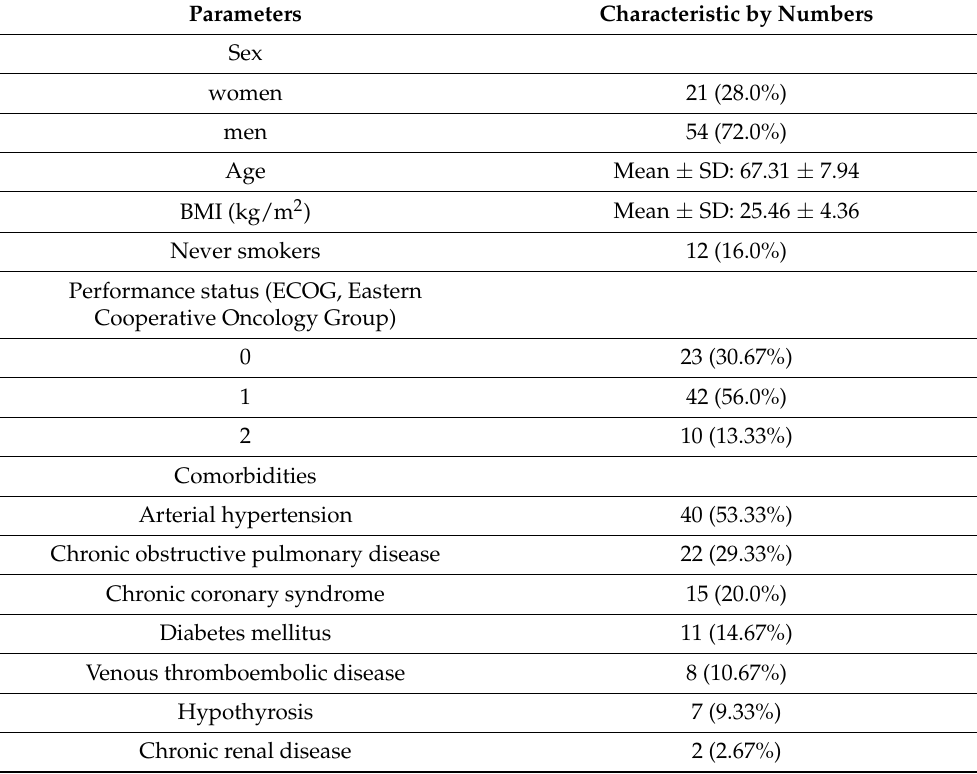
Table 1. Baseline characteristics of 75 patients with lung cancer evaluated by echocardiography. Parameters Characteristic by Numbers Sex women 21